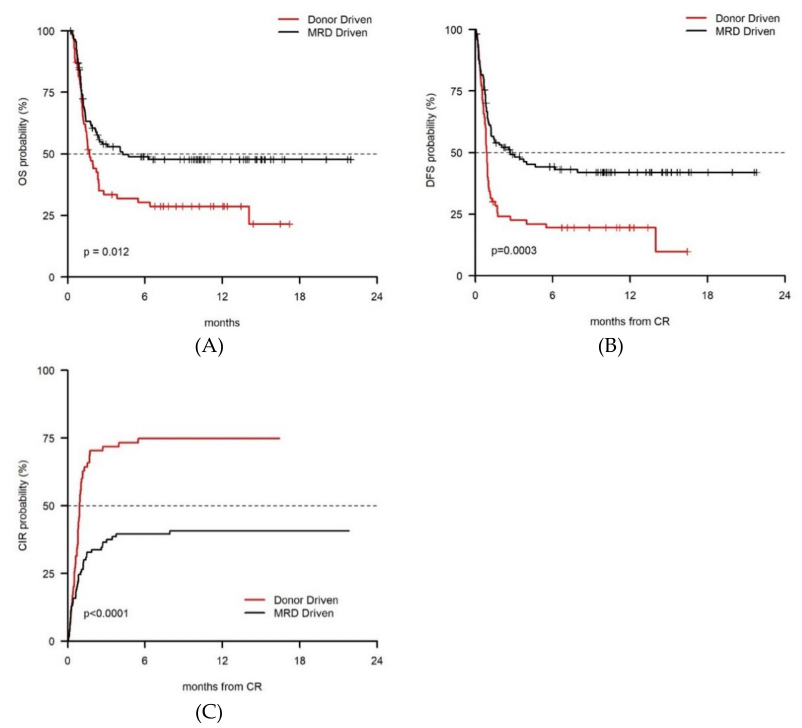
Figure 1. In the whole series, 10-yrs OS (47.7% vs. 28.7%, p = 0.012) and DFS (42.0% vs. 19.5%, p = 0.0003) were longer for 115 patients in the MRD-driven cohort as compared to 70 patients in the donor-driven cohort ( A , B ). Accordingly, CIR (40.7% vs. 74.8%, p < 0.001) was lower in the MRD-driven cohort ( C